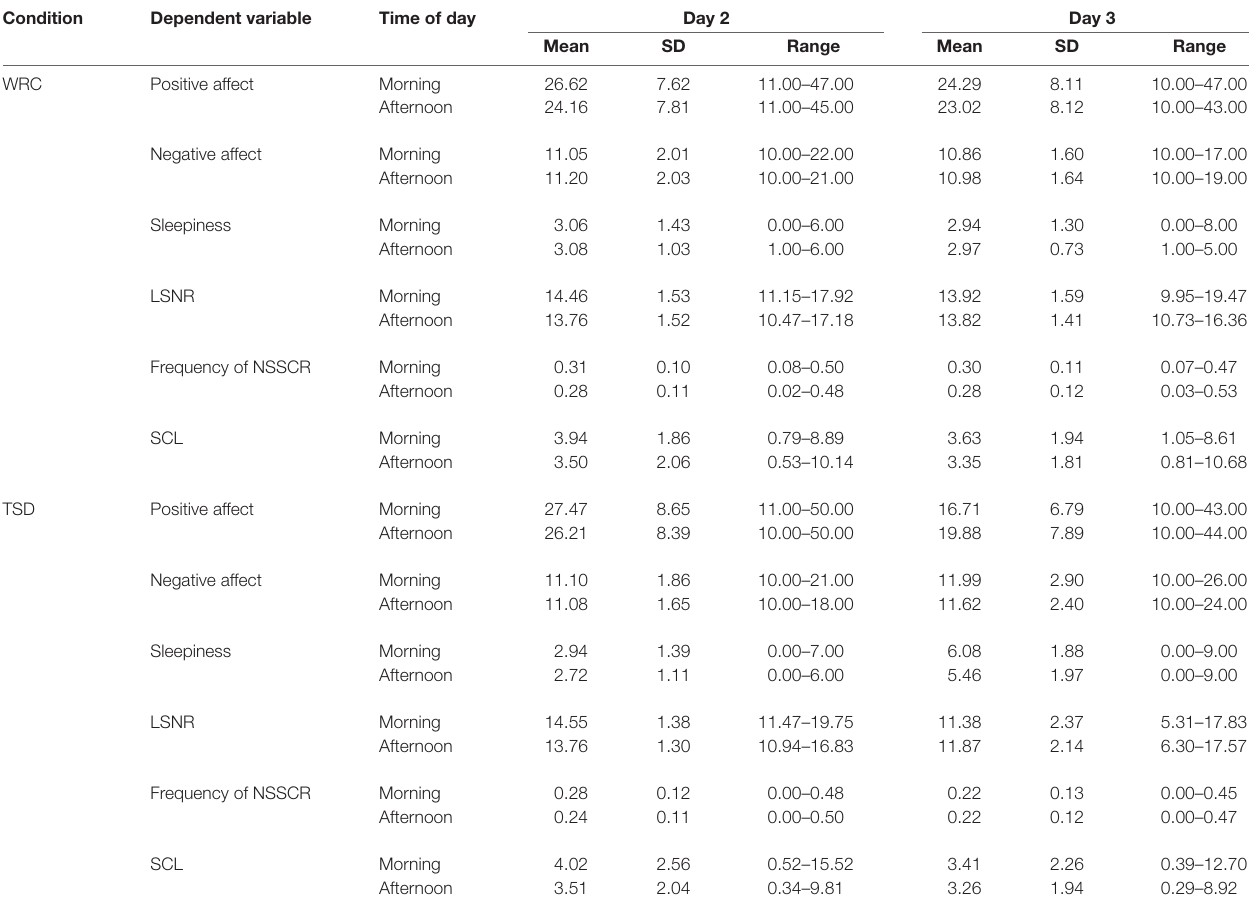
TABLE 1 | Descriptive statistics for all dependent variables by condition, day, and time of day.